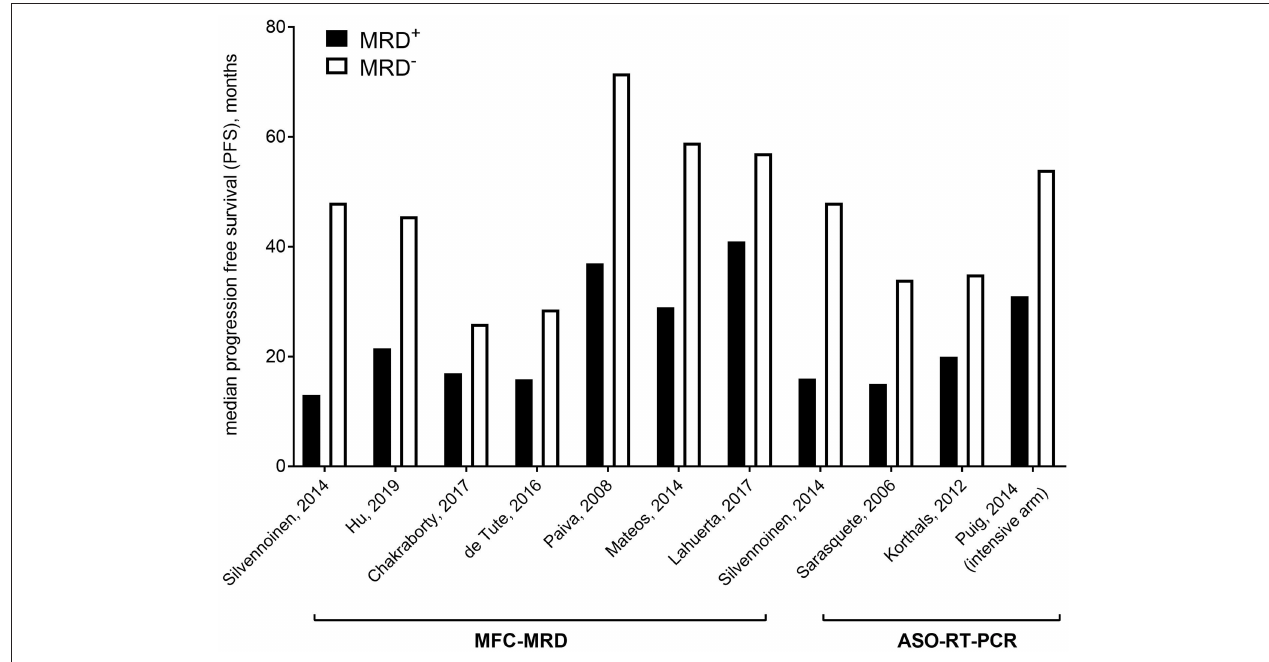
FIGURE 1 | Median progression free survival based on MFC/ASO-qRT-PCR MRD in selected studies.